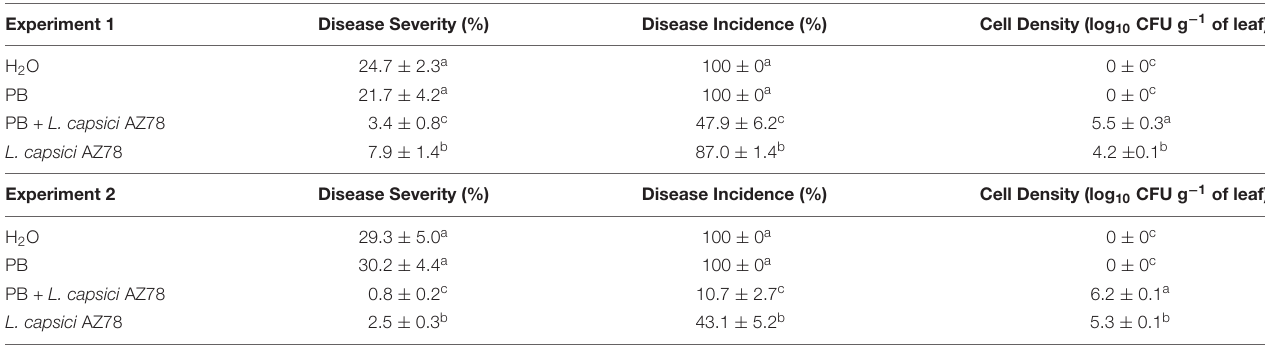
TABLE 2 | Effect of pea broth on the plant protection efficacy of Lysobacter capsici AZ78. Experiment